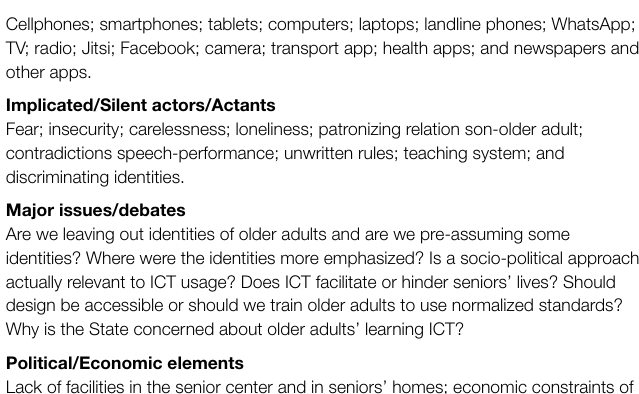
TABLE 2 | Ordered version of elements that constitute this research. Template retrieved from Clarke et al. (2018). Individual human elements/Actors Non-human elements actors/Actants Fifteen initial and diverse seniors; seniors in the senior center; teachers; seniors during COVID-19; researcher (participant, observer, and interviewer); seniors’ children and grandchildren; and wife–husband.